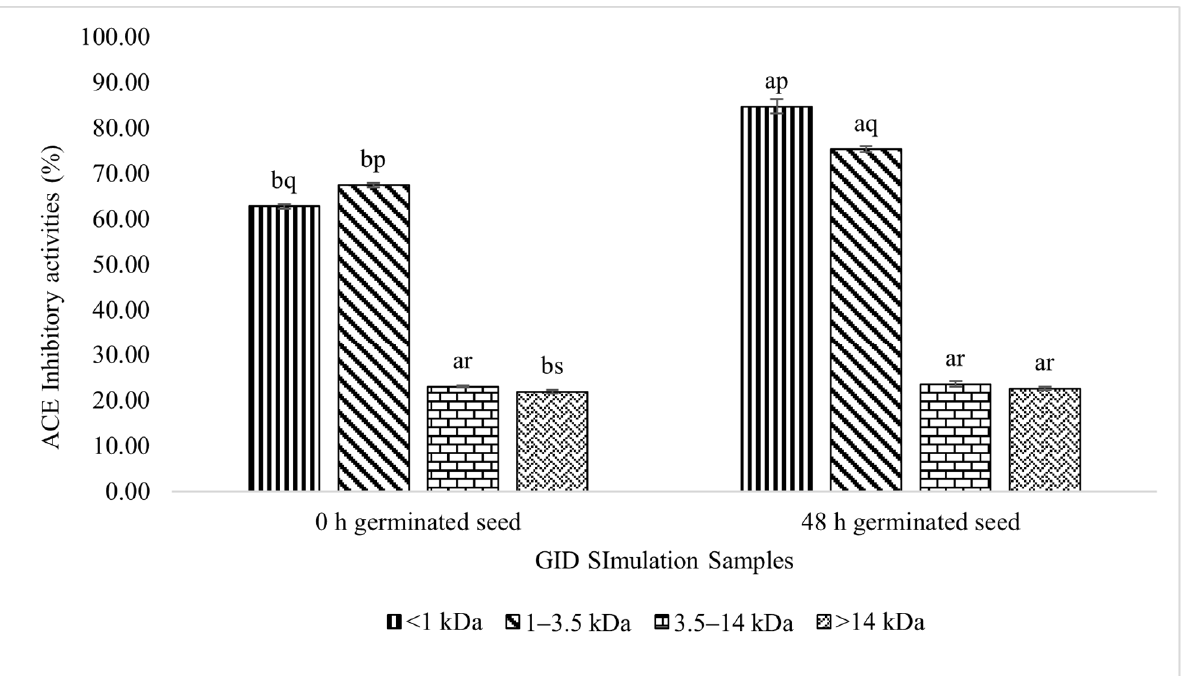
Figure 5. ACE-I activity of the germinated lamtoro gung flour peptide in different fractions after the GID simulation. Values are means with their SDs. a and b indicate significant differences between the same peptide fraction in different samples ( t -test, α = 0.05). p, q, r, and s indicate significant differences between the different peptide fractions in the same sample (Duncan’s test, α = 0.05).